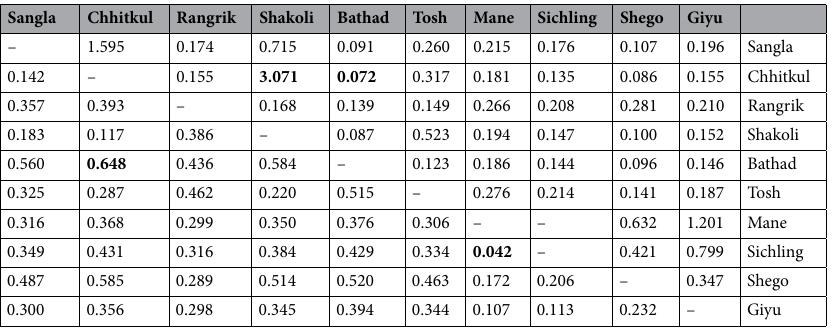
Table 3. Genetic differentiation coefficient Fst (below diagonal) and gene flow Nm (above diagonal) between 10 populations of Dactylorhiza hatagirea .